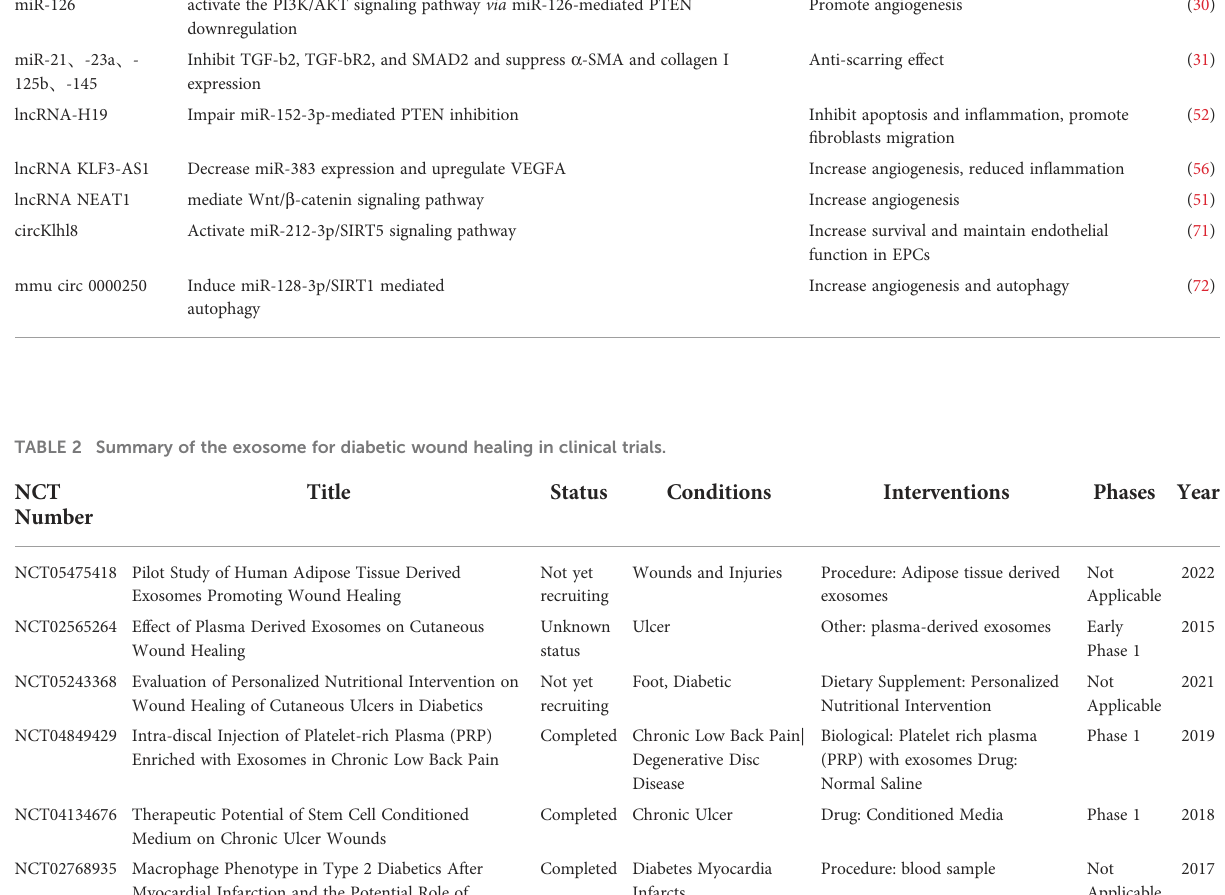
Completed Diabetes Myocardia Infarcts